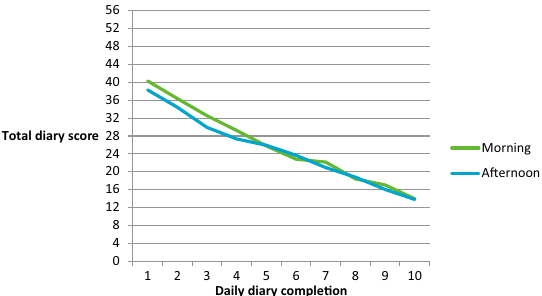
Fig. 5 Total score of morning vs. afternoon chest-related ePRO diary summary scores from Day 1 to Day 10 (N